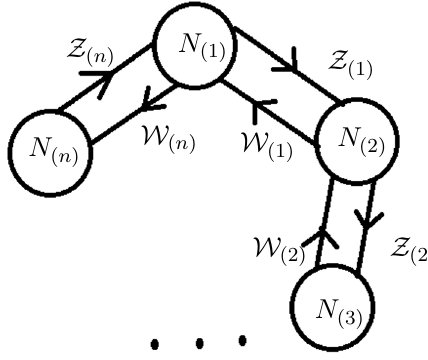
Figure 1 . b A n (cid:0) 1 quiver